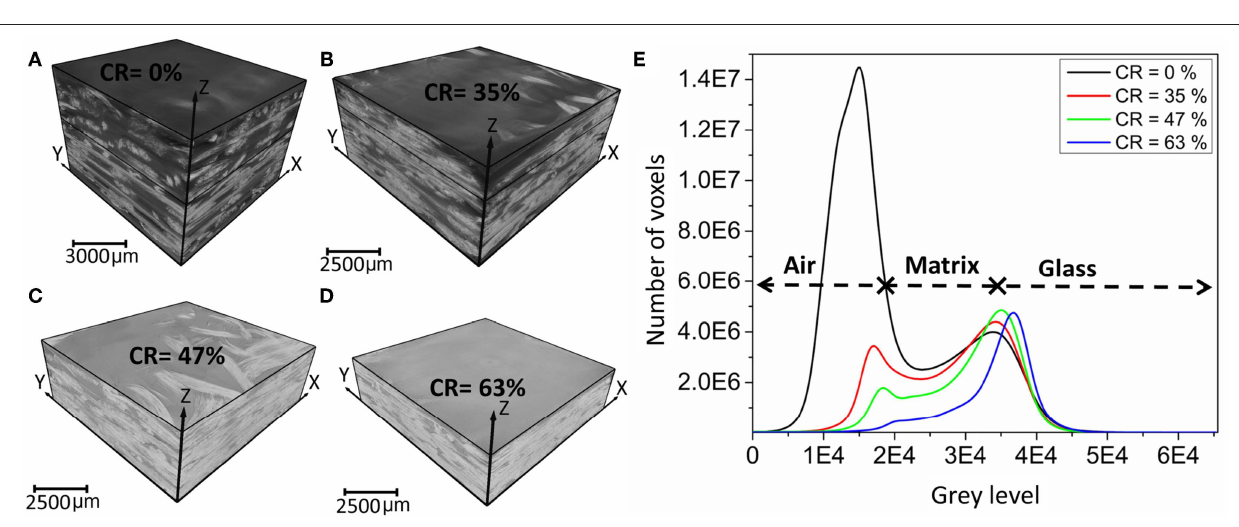
FIGURE 3 | (A–D) µ CT images for all the compaction ratios. (E) Corresponding histograms of gray